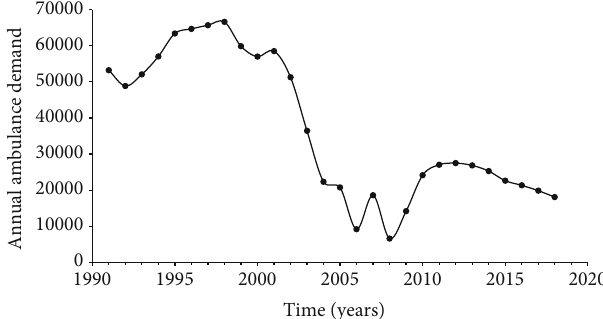
Figure 1: Annual public emergency ambulance demand, Bulawayo, Zimbabwe